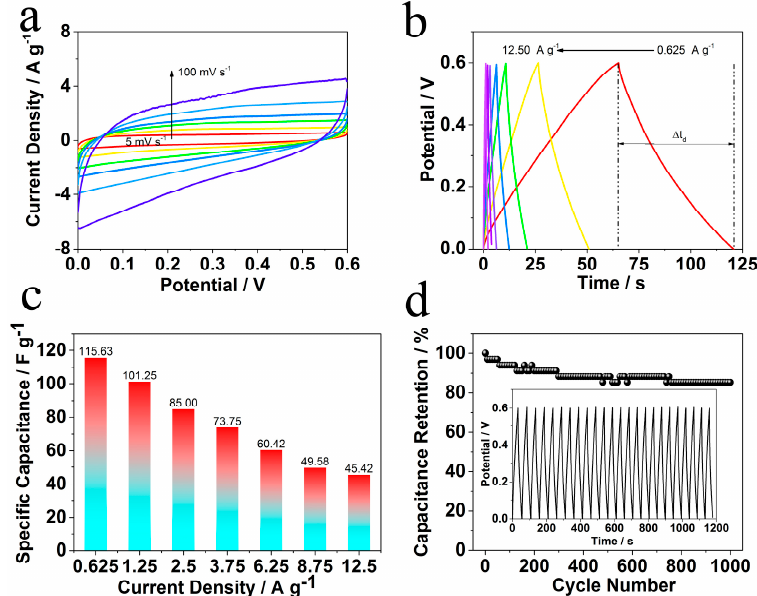
Figure 9. ( a ) CV experiments of as ‐ prepared MnPO 4 ∙ H 2 O nanowire/GO in a symmetric double